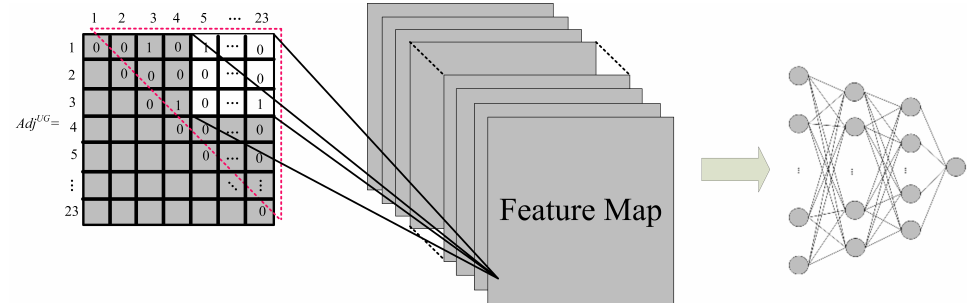
Figure 8. Scheme of applied